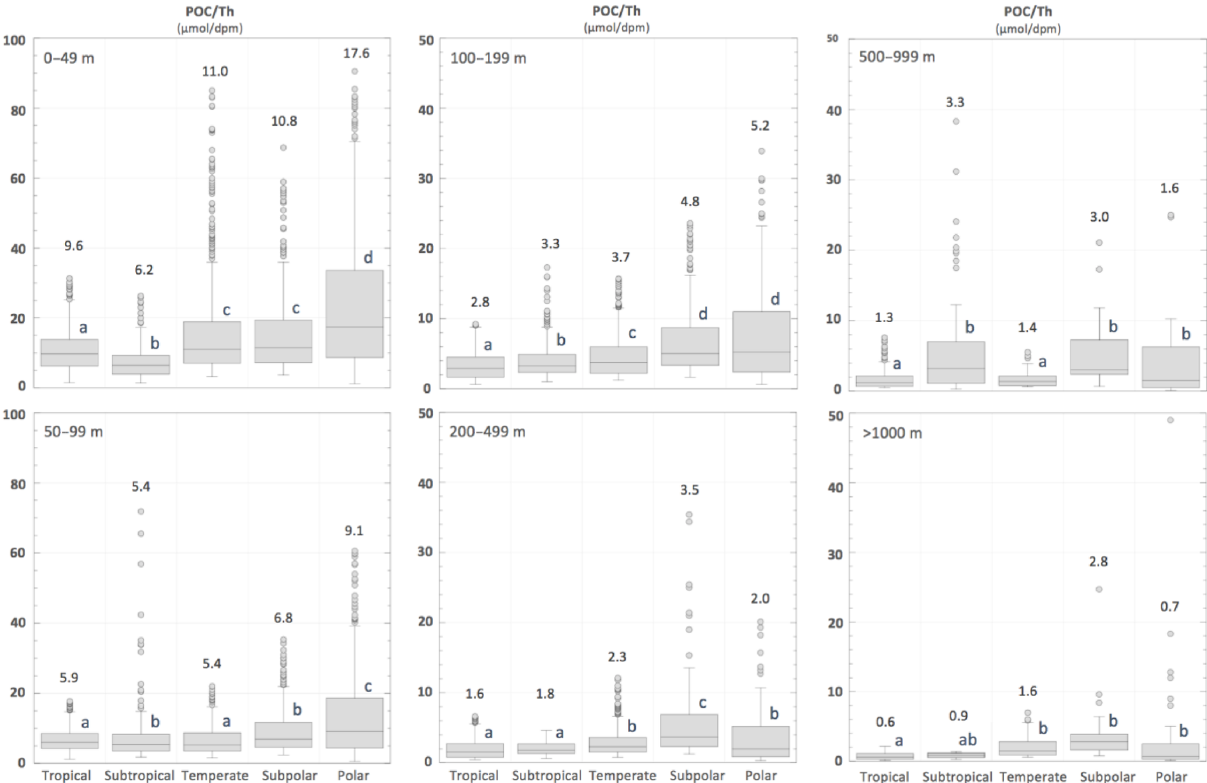
Figure 4. POC / Th ratio variability (box–whisker plots) of 90% of the data sorted by climate zones and depth. The values shown on top of each box represent their median. Box plots within the same depth range (e.g., 0–49m) sharing a letter are not significantly different. Note the different scale used between the 0 to 99m and the 100 to > 1000m